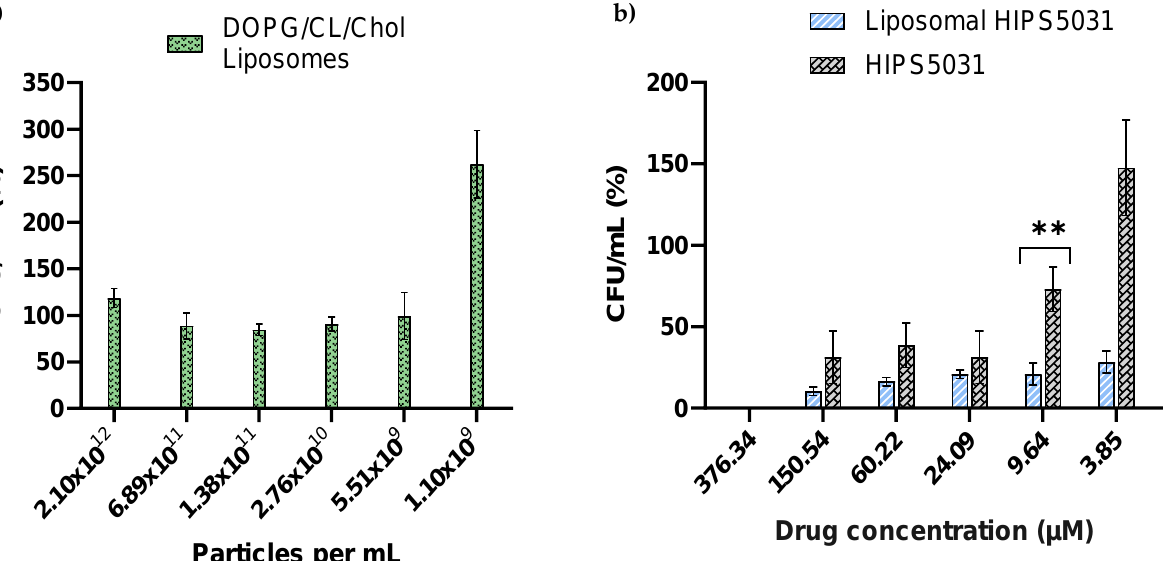
Figure 5. Bacterial growth inhibition assay of free vs. liposomal HIPS5031 (DOPG/CL/Chol) performed on the Gram-positive model organism Bacillus subtilis . Effects were determined as a reduction in CFU/mL and were normalized to an untreated control (particle-free PBS). ( a ) Blank DOPG/CL/Chol liposomes show no intrinsic growth-inhibiting effect. The particle number (= number of liposomes) as determined by NTA was adjusted to that of drug-containing samples; in the range of 2.10 × 10 12 –5.51 × 10 9 particles per mL, treatment with DOPG/CL/Chol liposomes did not lead to significant changes of CFU/mL compared to the control (PBS). ( b ) Liposomal HIPS5031 reduced the growth of B. subtilis significantly at all concentrations tested ( p = 0.008 at 3.85 µM) and was found to be superior to the free drug at a concentration of 9.64 µM ( p = 0.004) (ANOVA followed by Holm–Sidak post hoc test). Values of the abscissa represent the concentration of either free or liposomal HIPS5031 . ** p = 0.01.